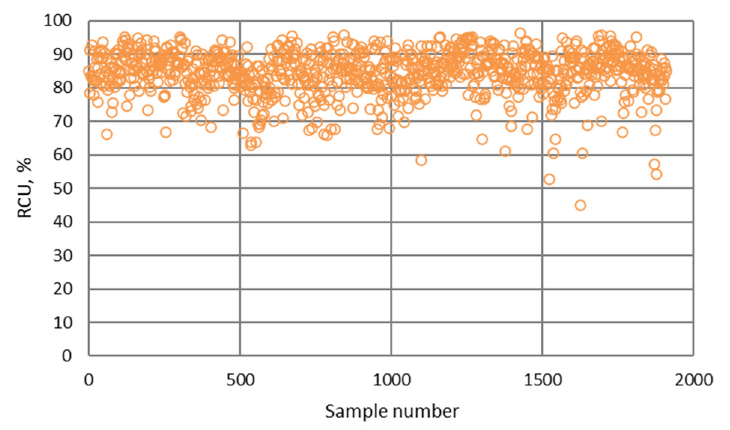
Figure A22. PMM model—testing dataset for RCU output variable.